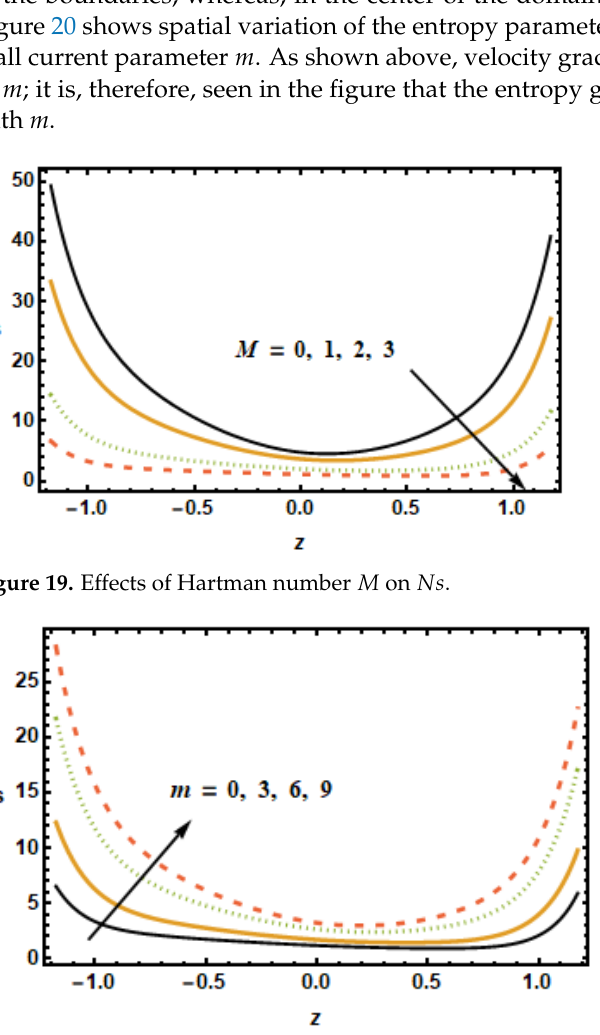
m on Ns . m on Ns .